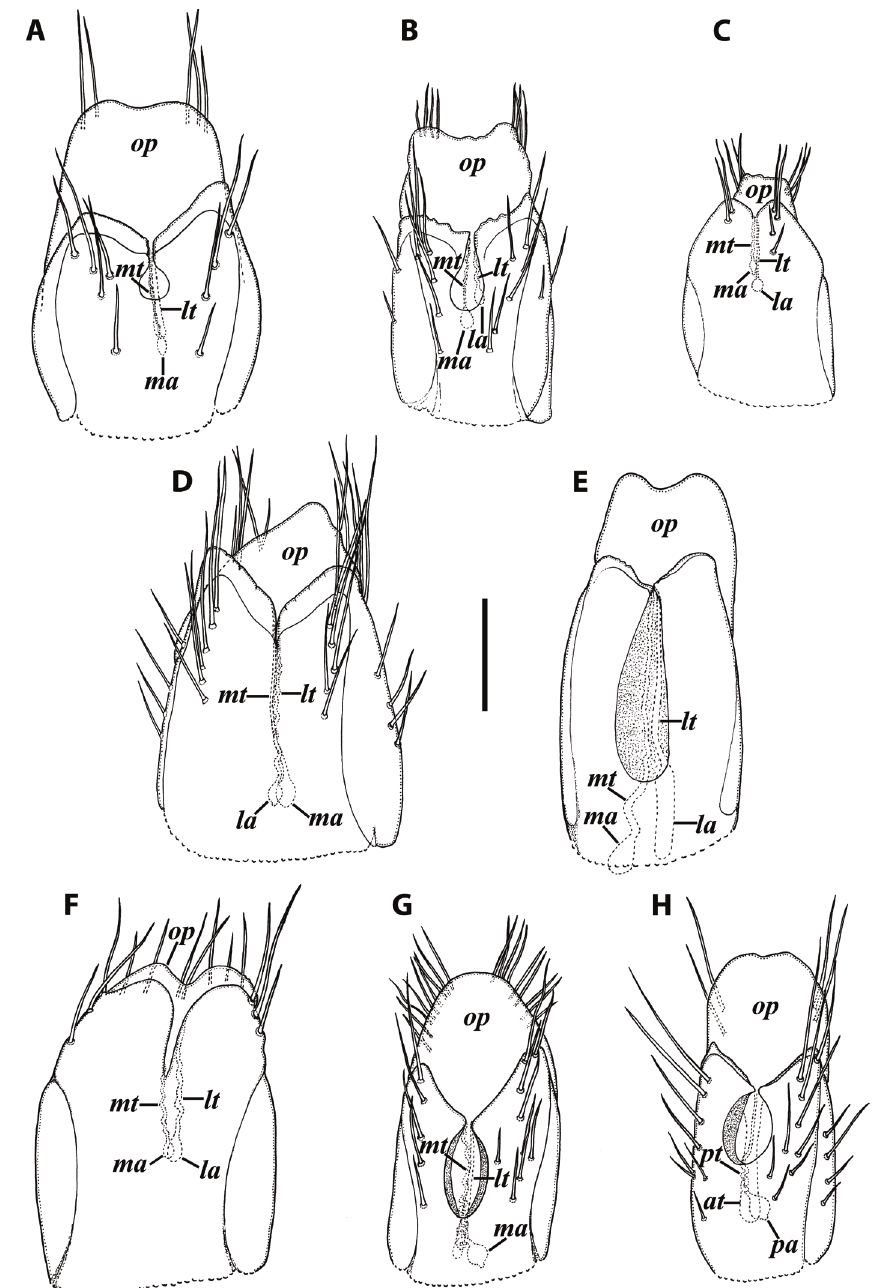
Fig. 11. Left vulvae of species of Stygiiulus stat. nov. (A–D) and representatives of (other) Julini/ Leptoiulini (E) and Typhloiulini/blind Julini/Leptoiulini in caudal, somewhat mesal views. A . S. ausugi (Manfredi, 1953) comb. nov., ♀ from Grotta [Cave] del Calgeron (NHMD). B . S. illyricus (Verhoef, 1929) comb. nov., ♀ from Rabakova Cave (IZB). C . S. insularis (Strasser, 1938) comb. nov., topotype ♀ (CBSS). D . S . tobias (Berlese, 1886) comb. nov., ♀ from Grotta [Cave] del Subiolo (NHMD). E . Leptoiulus cf. trilineatus (C.L. Koch, 1847), ♀ from Belasitsa Mtn, Bulgaria. F . Serboiulus spelaeophilus Gulička, 1967, ♀ from Vodni Pech Cave (NMNHS). G . Typhloiulus ( Inversotyphlus ) lobifer Attems, 1951, ♀ from Minjera-Bauxite Mine (IBER). H . Typhloiulus (s. str.) strictus (Latzel, 1882), ♀ from Kunino (IBER). Abbreviations: at = anterior tube; la = lateral ampulla; lt = lateral tube; ma = median ampulla; mt = median tube; op = operculum; pa = posterior ampulla; pt = posterior tube. Scale bar = 0.2